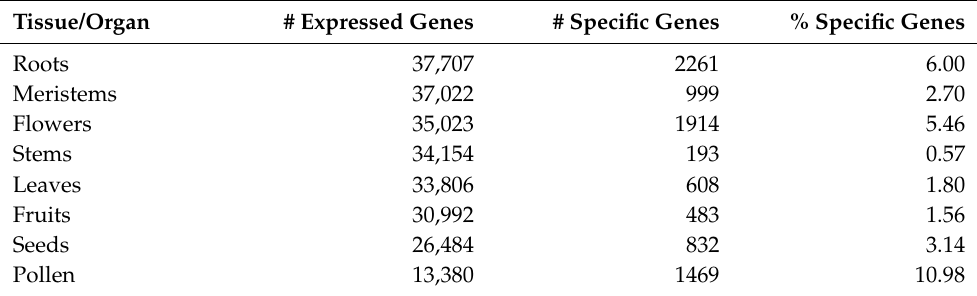
Figure 1. Principal component analysis of OliveAtlas ‘Picual’ samples. ( A ) PCA of all samples. ( B ) Detailed distribution of samples excluding seeds and pollen datasets. Orange ellipse groups pollen samples, purple ellipse groups seed samples, blue ellipse groups stress experiments conducted in roots, red ellipse groups plant organs under control conditions and green ellipse groups leaf experiments under stress conditions. Table 2. Summary of the number of genes expressed in each ‘Picual’